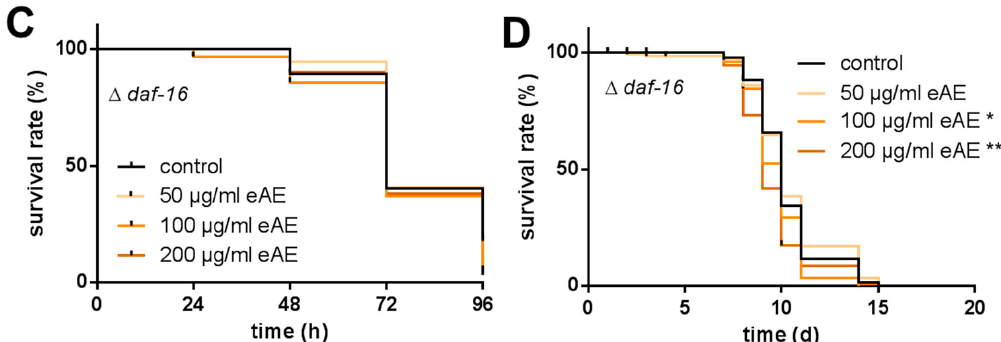
Figure 4. Requirement of DAF-16 for the protective effects of eAE. ( A ) Thermally induced increase in ROS (DCF assay): L4 larvae deficient in DAF-16 were treated with different concentrations of eAE or with DMSO (vehicle, 0.4%) for 24 h at 20 ◦ C. After washing, they were transferred individually into the wells of a 384-well plate containing 50 µ M H 2 DCF-DA. The increase in fluorescence was measured at 37 ◦ C. Values are mean ± SD, n = 3 (each 16 individuals per group), two-way ANOVA with Dunnett’s multiple comparisons test vs. control at the correspondent time point, ** p ≤ 0.01, *** p ≤ 0.001, **** p ≤ 0.0001; ( B ) Thermal stress resistance: L4 larvae deficient in DAF-16 were treated with different concentrations of eAE or with DMSO (vehicle, 0.4%) for 24 h at 20 ◦ C. After washing, they were transferred individually into the wells of a 384-well plate containing 1 µ M SYTOX ® Green. The increase in fluorescence was measured at 37 ◦ C. The graph shows the percentage of viable nematodes. Kaplan-Meier statistics were used for the comparison of the survival curves, n = 3 (each 16 individuals per group), Log Rank (Mantel-Cox) test; ( C ) Oxidative stress resistance: L4 larvae deficient in DAF-16 were incubated with eAE or with DMSO (vehicle, 0.4%) for 72 h at 20 ◦ C. Then, all nematodes were transferred into extract-fee media containing 50 mM paraquat. Every 24 h, the survival of the nematodes was surveyed via touch-provoked movement. Kaplan-Meier statistics were used for the comparison of the survival curves, n = 3 (each 40 individuals per group), Log Rank (Mantel-Cox) test; ( D ) Modulation of life span: L4 larvae deficient in DAF-16 were incubated with different concentrations of eAE or DMSO (vehicle, 0.4%). On five days a week, media were exchanged and survival of the nematodes was tested via touch-provoked movement. Kaplan-Meier statistics were used for the comparison of the survival curves, n = 3 (each 40 individuals per group), Log Rank (Mantel-Cox) test, * p ≤ 0.05, ** p ≤ 0.01. Calculated data for thermal and oxidative stress resistance, as well as lifespan, are shown in Supplementary Tables S1–S3.